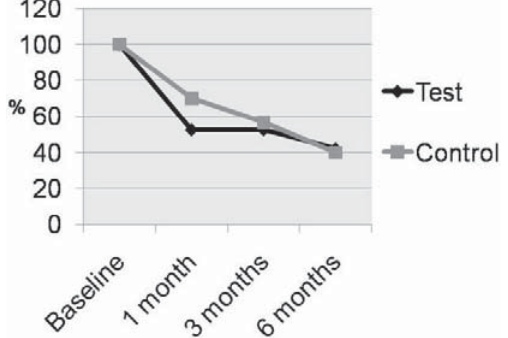
Figure 1- Bleeding on probing (BOP) of furcation involvements at different time intervals for control and test groups Figure 2- Percentage of furcation involvements with (cid:23)(cid:20)(cid:14)(cid:6)(cid:11)(cid:12)(cid:15)(cid:3) (cid:23)(cid:14)(cid:17)J(cid:9)(cid:5)(cid:3) (cid:18)(cid:9)(cid:23)(cid:5)(cid:24)(cid:3) !(cid:28)(cid:28)K<(cid:3) Q+(cid:3) (cid:22)(cid:22)(cid:3) (cid:7)(cid:5)(cid:18)(cid:11)(cid:19)(cid:19)(cid:9)(cid:20)(cid:9)(cid:12)(cid:5)(cid:3) (cid:5)(cid:11)(cid:22)(cid:9)(cid:3) intervals for control and test groups. * Difference (p<0.05) between groups by chi-square test.